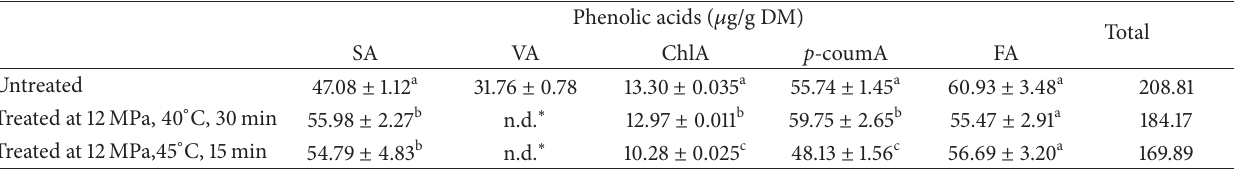
Table 2: Phenolic acids content of untreated and treated coconut extracts.